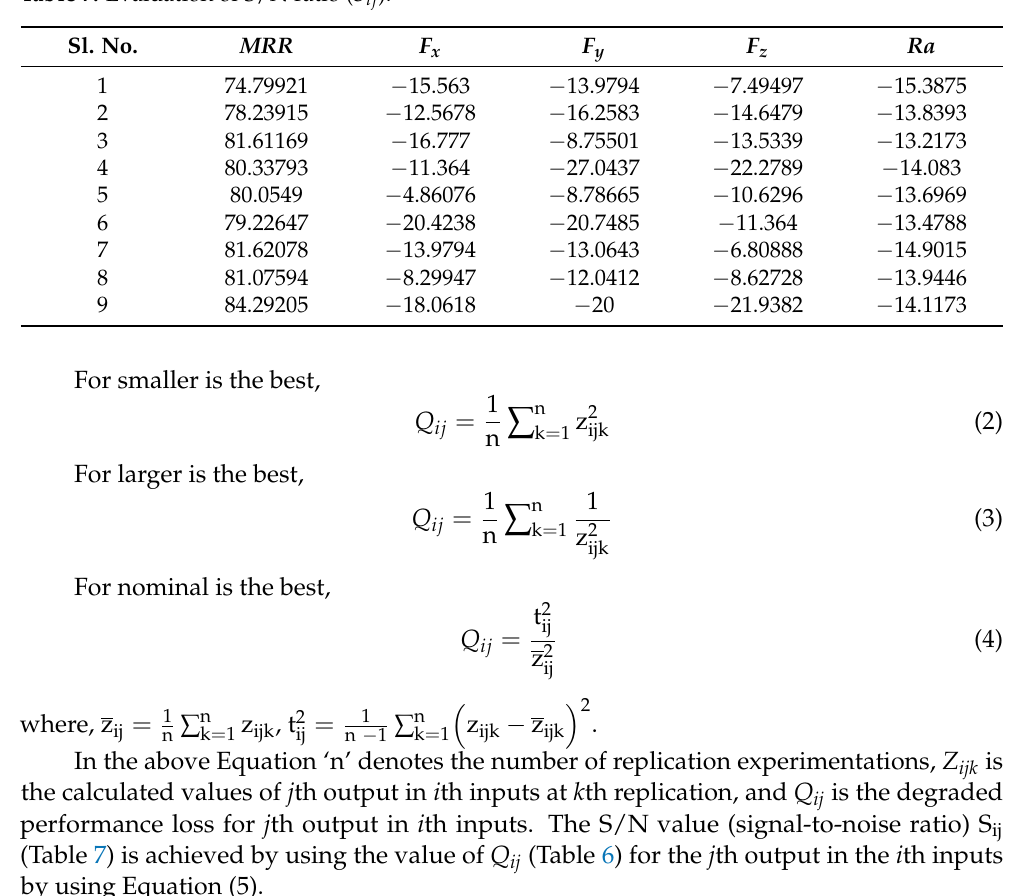
Table 7. Evaluation of S/N ratio ( S ij